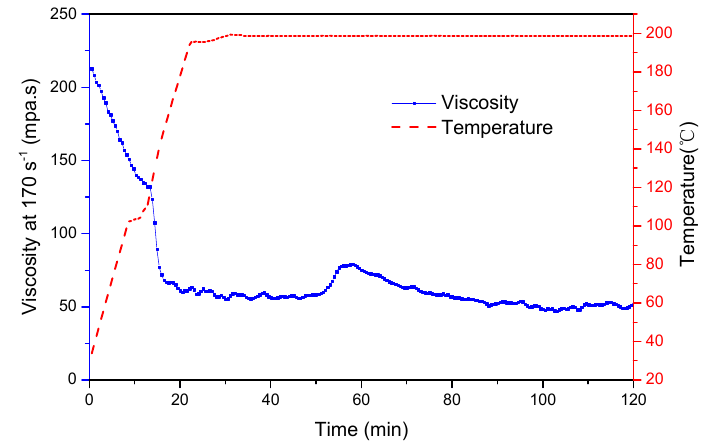
Figure 8. Viscosity vs. time of the 0.6 wt% PAANM (10% NVP) solution with 150 ppm of PEI and 1000 ppm of